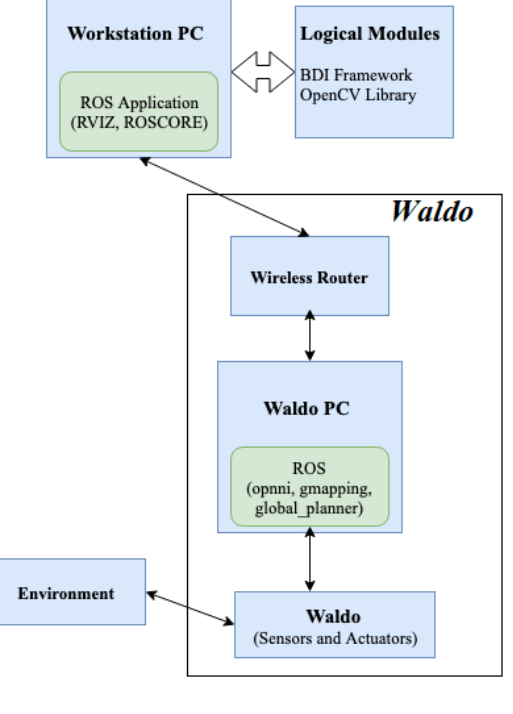
Figure 2. System